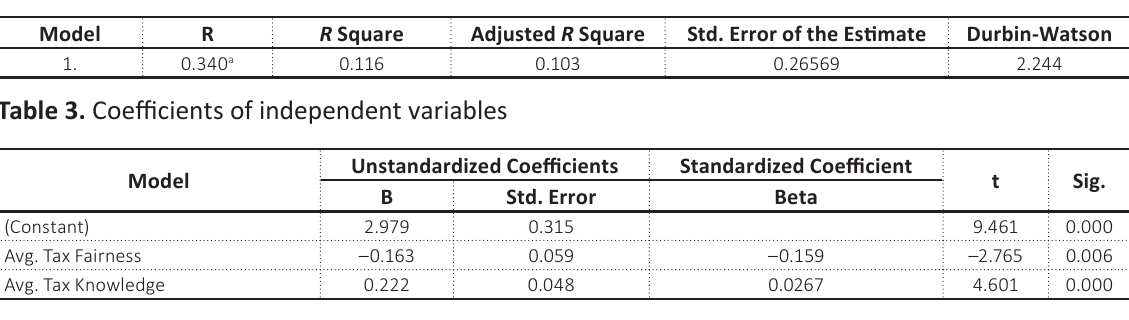
Table 2. Model summary